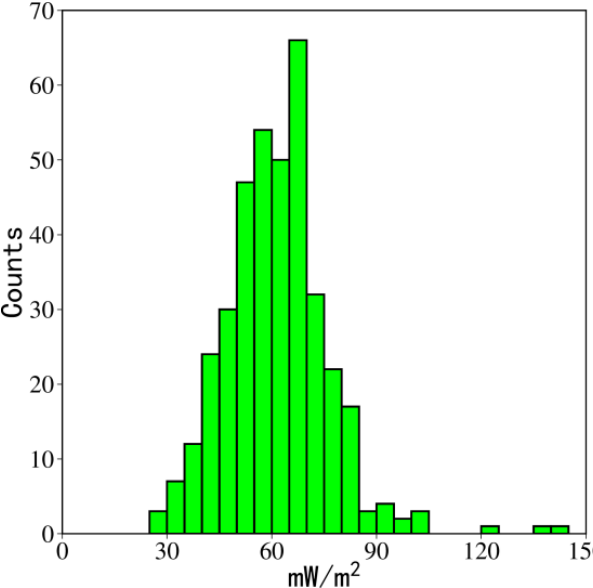
Figure 2. Histogram of heat flow values.